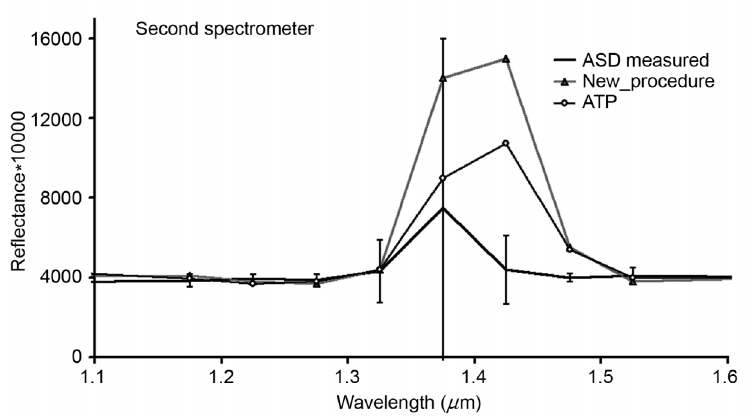
Fig. 6. Comparison of APT and new calibration spectrum of the AOI in concrete with respect to ASD re- flectance. ASD measure is plotted with one sigma errors bars.